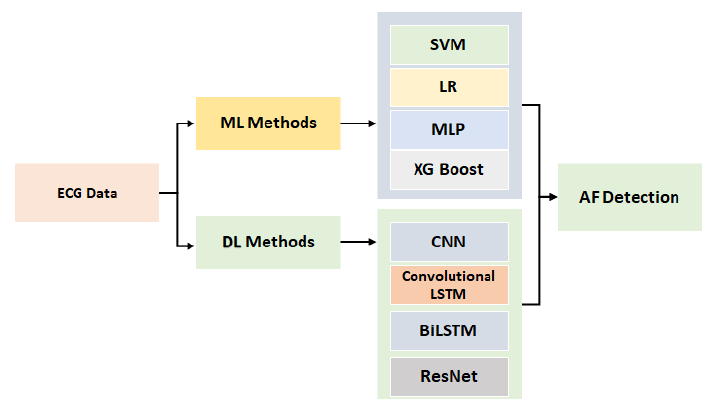
Figure 1. An overview of the proposed framework for atrial fibrillation (AF)